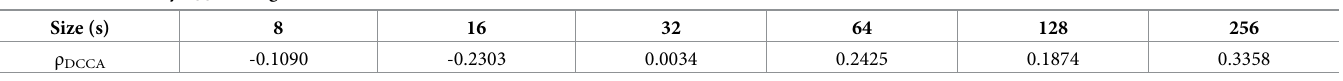
Table 2. The value of ρ DCCA for a given window size s.